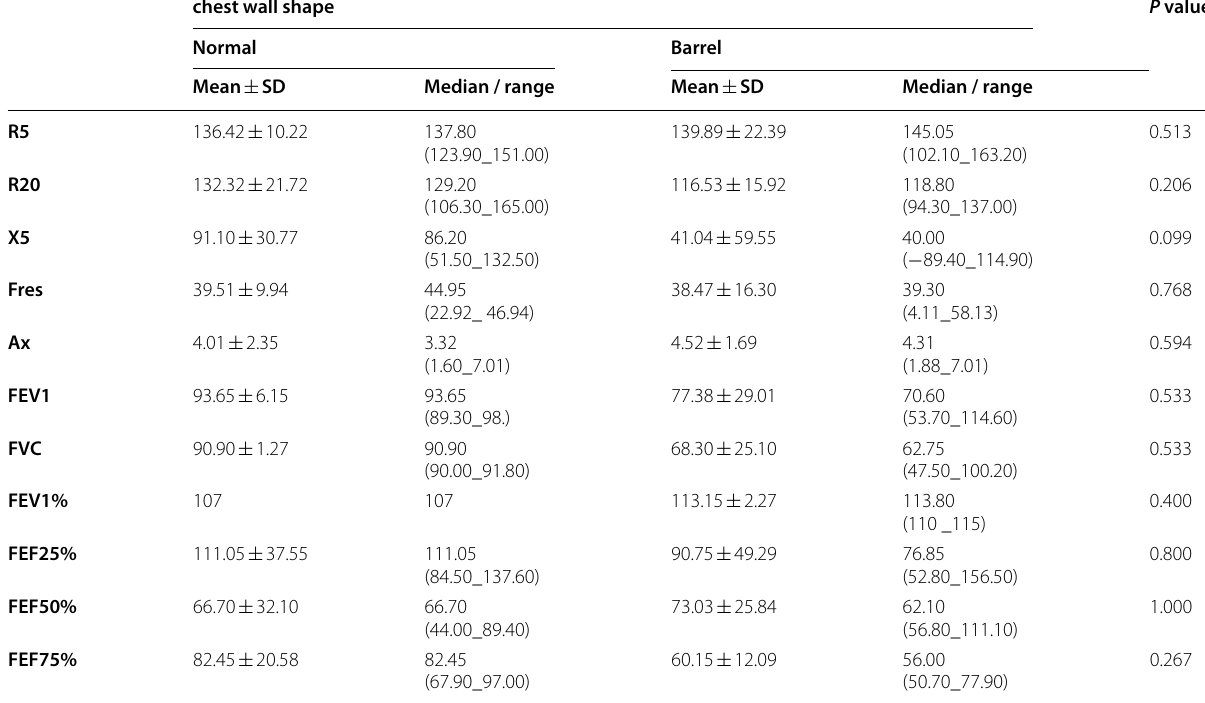
Table 5 Relation between chest wall shape and pulmonary function tests chest wall shape P